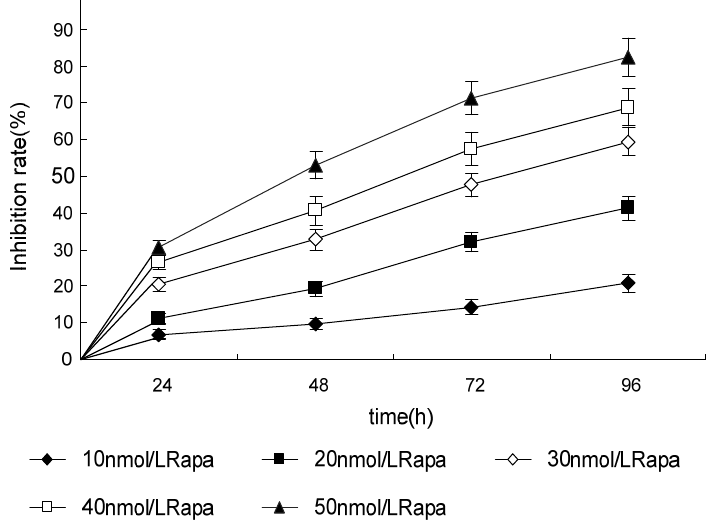
Figure 1. Growth inhibiting effects of Rapamycin (Rapa) on PC-2 cells. PC-2 cells were treated with different concentrations for 0–96 h. Cell viability was determined by